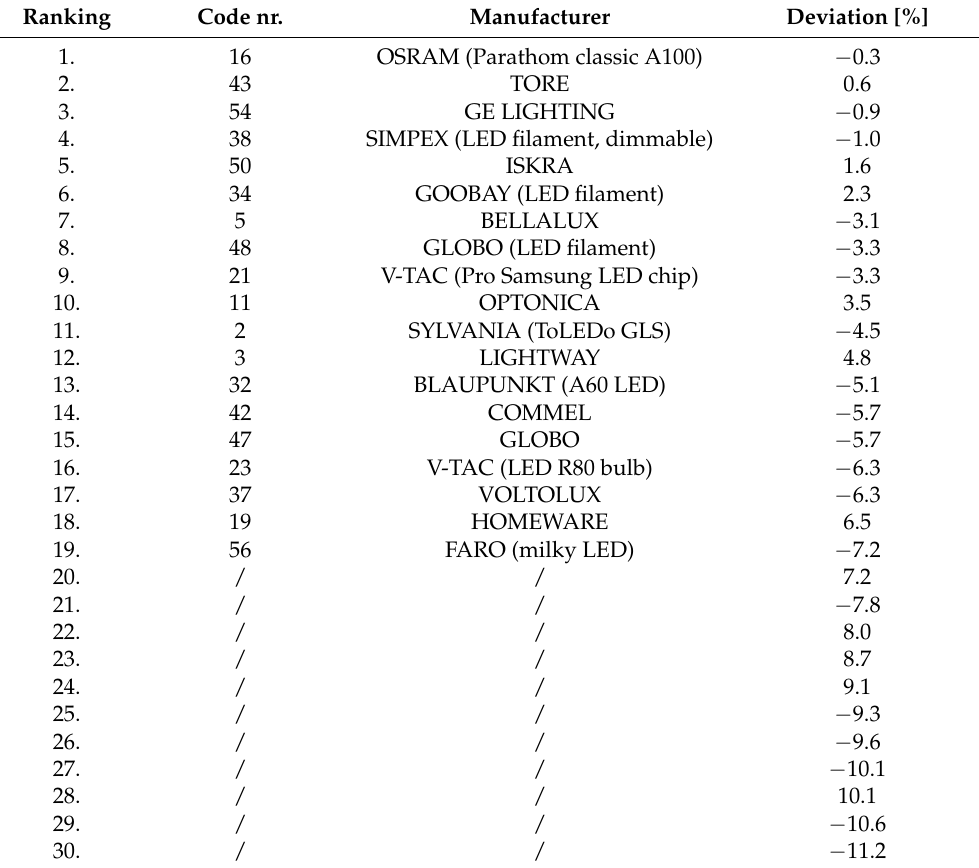
Table 3. Classification of LED light bulbs based on the percentage of deviation of the measured luminous flux value from the luminous flux value stated on the packaging. Ranking Code